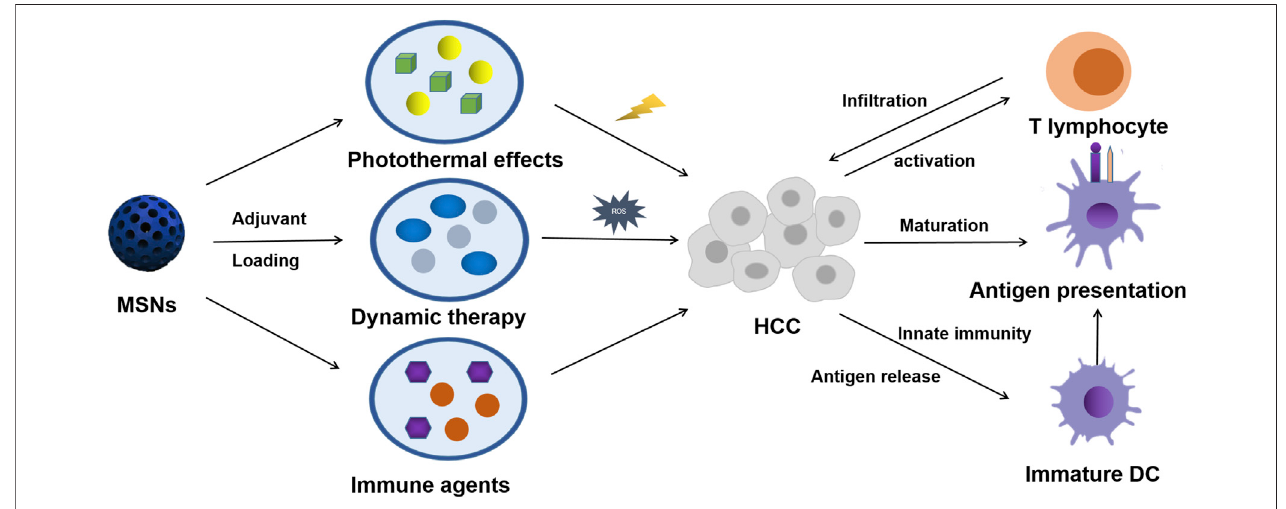
FIGURE 1 | Scheme of MSN-based therapy for triggering HCC systemic antitumor immunological